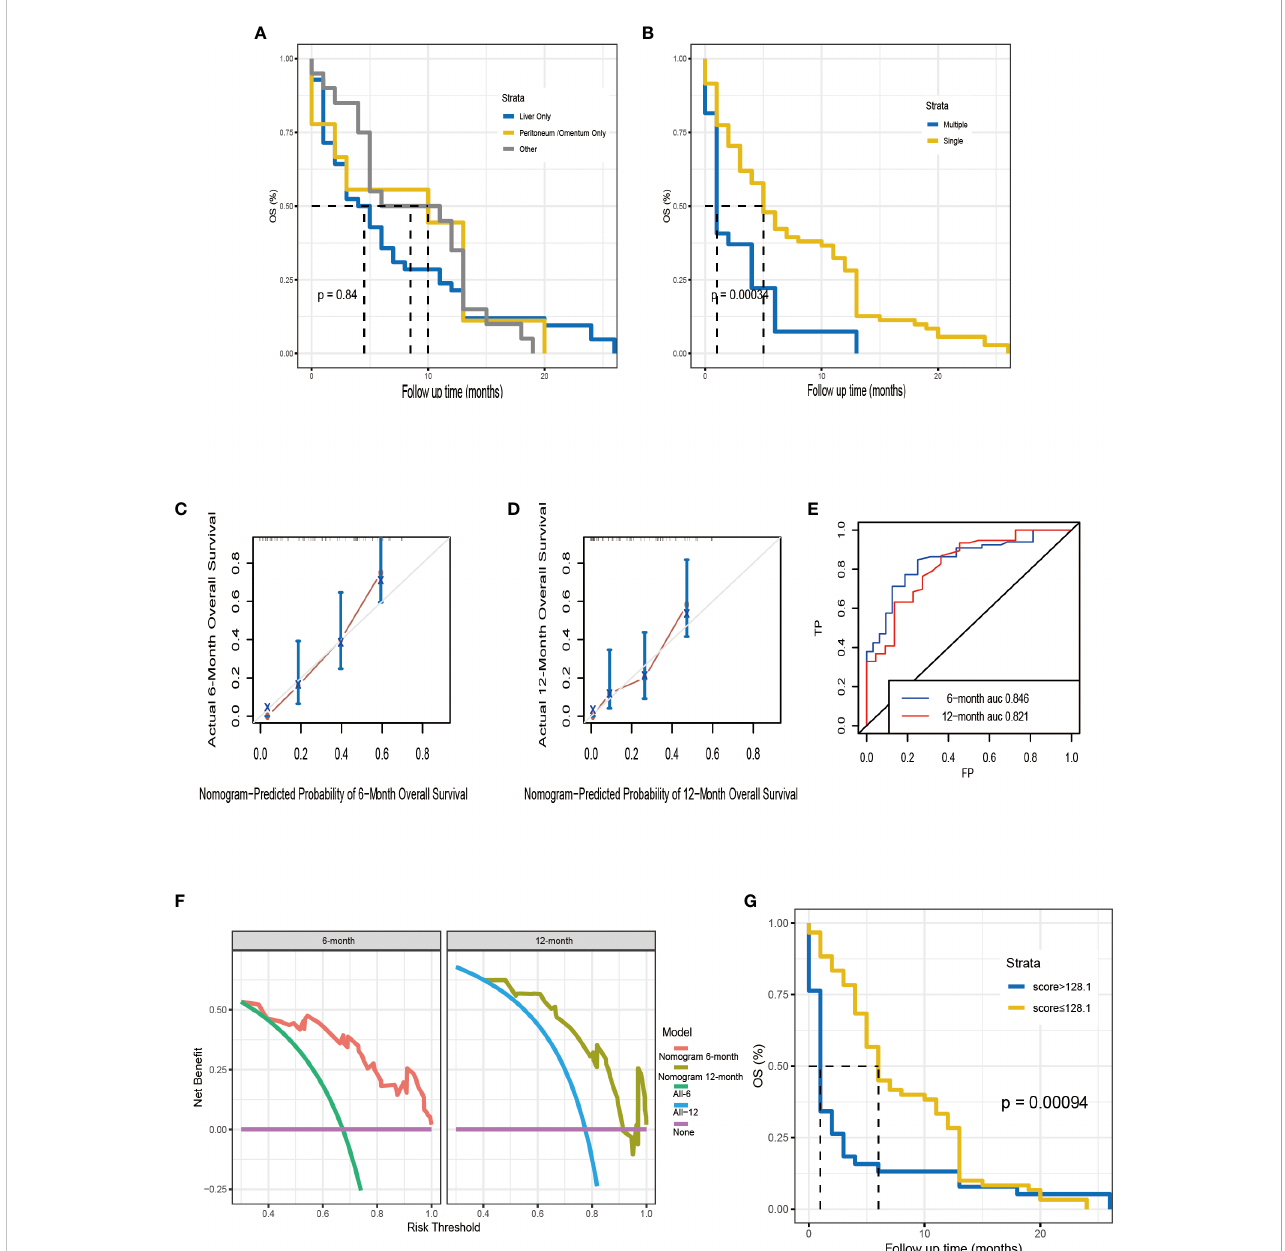
FIGURE 7 Kaplan – Meier analysis for OS of Chinese patients according to the metastatic site (A) . Kaplan – Meier analysis for OS of Chinese patients according to the number of distant metastases (B) . The calibration curves of the nomogram for the 6, 12 months in the external validation set (C, D) . Time-dependent ROC curve analysis of the nomogram for the 6, 12 months in the external validation set (E) . The DCA of the nomogram for the 6, 12 months in the external validation set (F) . The Kaplan – Meier survival curves of high-risk group and low-risk group in the Chinese cohort (G)